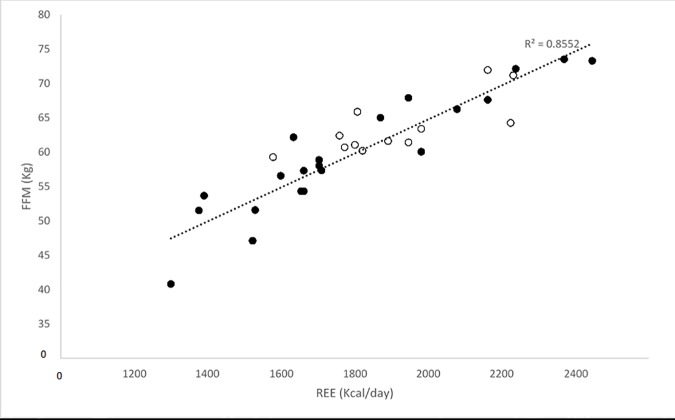
REE and FFM relationship in BeMD (closed circles) and Control participants (open circles).FFM = Fat Free Mass; Kg = Kilograms; REE = Resting Energy Expenditure; Kcal = Kilocalories.